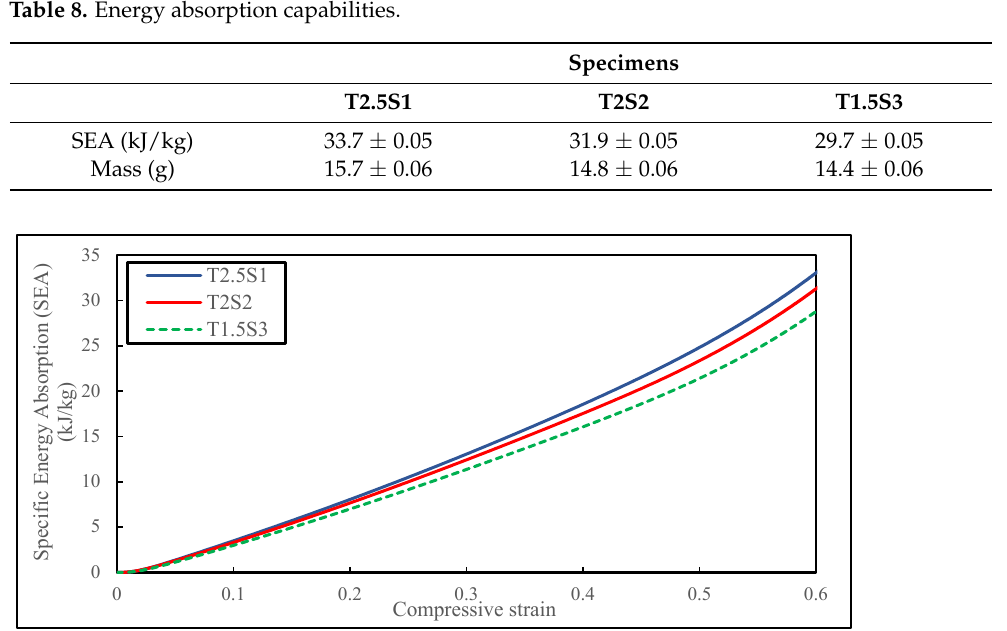
Figure 7. Comparison of SEA between biomimetic structures. Table 8. Energy absorption capabilities.